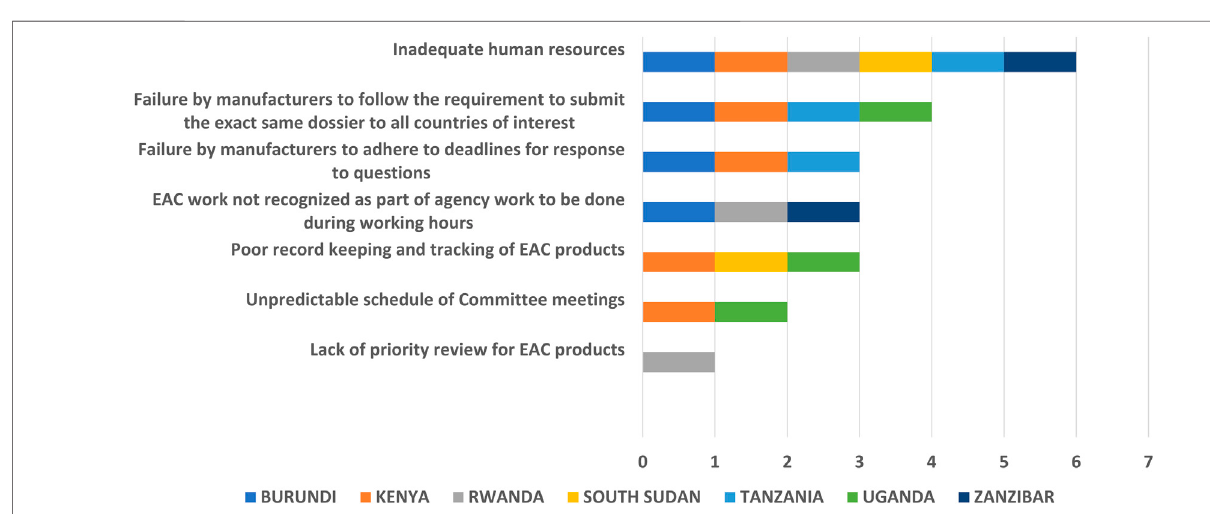
FIGURE 5 | Challenges assessing EAC-MRH products at country